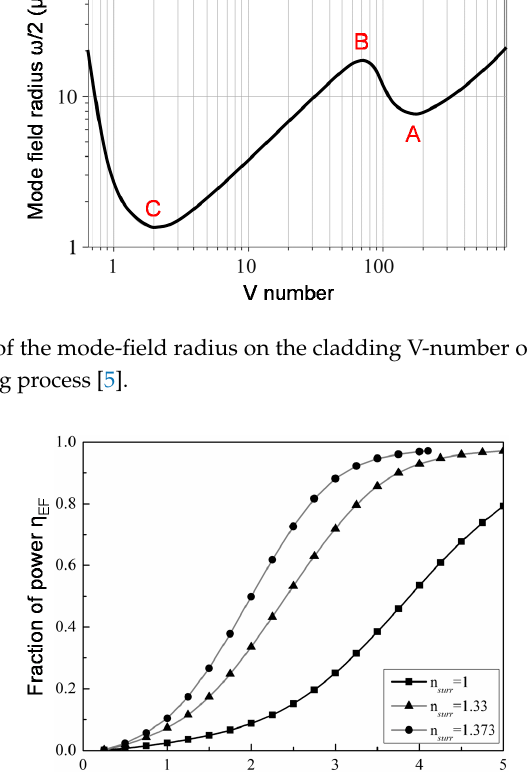
Figure 5. Dependence of the power fraction propagating in the evanescent field on the wavelength- to-radius ratio in different refractive index surroundings [5].